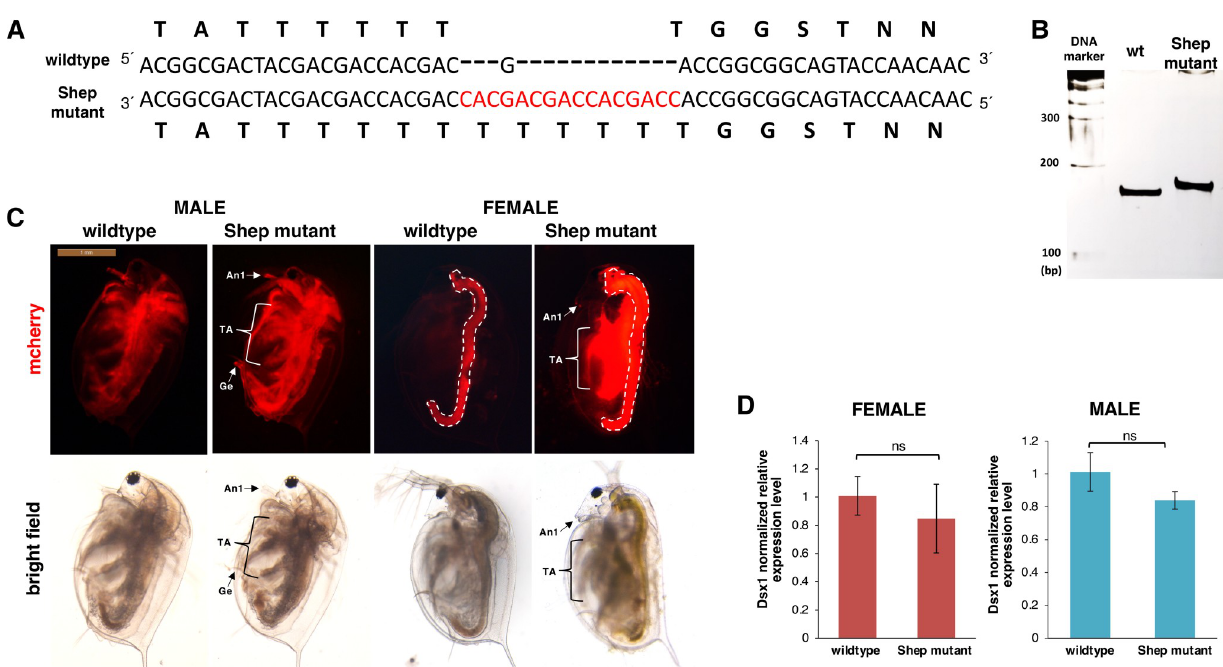
Fig 3. Generated Shep mutant line. (A) Nucleotide and amino acid sequence comparison between wildtype and Shep mutant. (B) PAGE analysis of PCR products by genomic PCR to amplify the Cas9/gRNA targeting region in the Shep coding sequence in the Shep mutant line. (C) Lateral view of the 2w Shep male and female mutant lines showing increase in mCherry fluorescence. The red signal from the guts (dotted lines) represents the autofluorescence of Chlorella , the main food used in daphniid cultivation. An1: first antennae, TA: thoracic appendages, Ge: genital. (D) Gene expression profile of Dsx1 in 1w female and male wildtype control and Shep -. RT-qPCR results are shown as expression levels normalized with housekeeping genes L32 , L8 and Cyclophilin and relatively compared to the wildtype control. Error bars indicate the standard error of the mean (n = 3). ns: not significant (Student’s T- test).